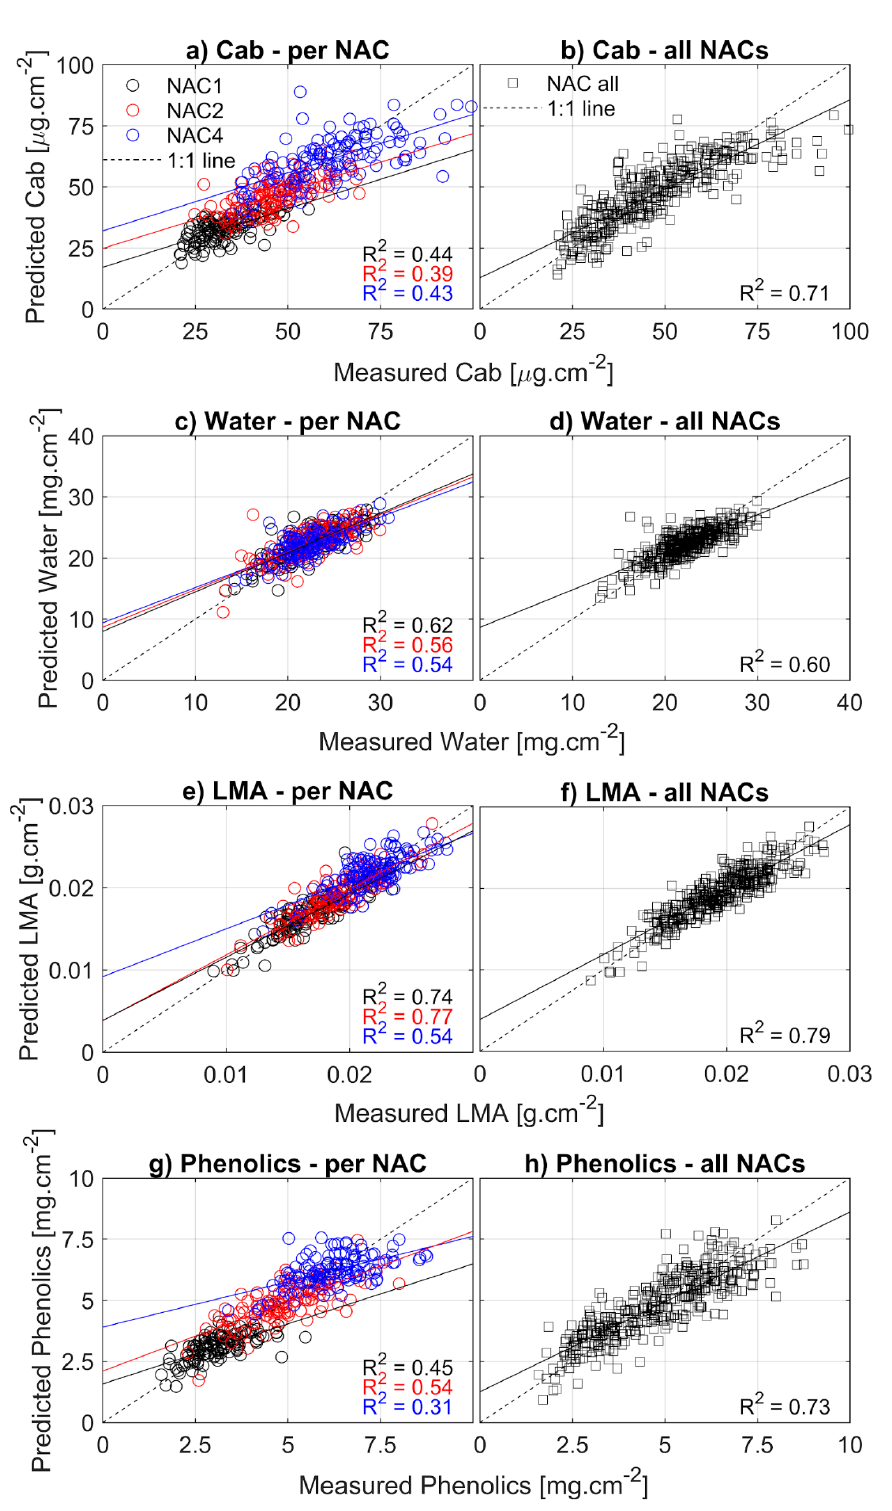
Figure 7. PLSR model validation (Cross-validation, leave-one-out) for selected needle traits. Chloro- phyll a+b content (Cab) for ( a ) individual needle age classes and ( b ) all NACs together; water content for ( c ) individual needle age classes and ( d ) all NACs together. Leaf mass per area (LMA) for ( e ) in- dividual needle age classes (NAC) and ( f ) all NACs together; phenolics content for ( g ) individual needle age classes and ( h ) all NACs together. Individual needle age classes are shown in colors: NAC 1 in black; NAC 2 in red; NAC 4 in blue. Coefficients of determination (R 2 ) are shown for each